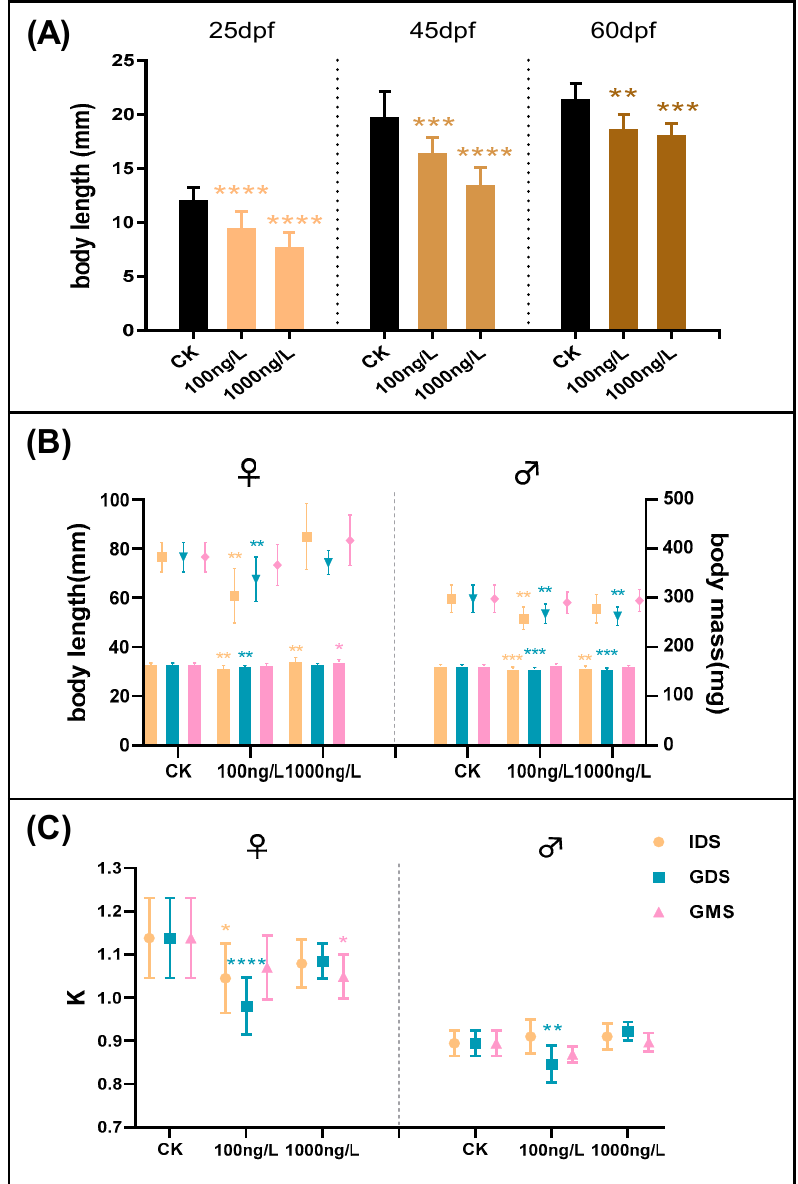
Figure 1. ( A ) Body length measured after diethylstilbestrol (DES) exposure at 25 dpf, 45 dpf, and 60 dpf, respectively. ( B ) Body length and body weight of zebrafish maintained after exposure, measured at 90 dpf. Different shapes of dots are body weight, and histogram is the body length (yellow is initial development stage (IDS), blue is gonadal differentiation stage (GDS), and pink is gonadal maturity stage (GMS)). ( C ) The plumpness (K) of zebrafish maintained after exposure, measured at 90 dpf. Values are shown as the mean ± SD ( n = 3 replicates per treatment, n = 11 fish per replicate at 25, 45, and 60 dpf, and n = 15 fish per replicate at 90 dpf). Asterisks denote significant differences between control and treatments (* p < 0.05, ** p < 0.01, *** p < 0.005, and **** p < 0.0001, according to Dunnett’s multiple comparisons test). CK-control